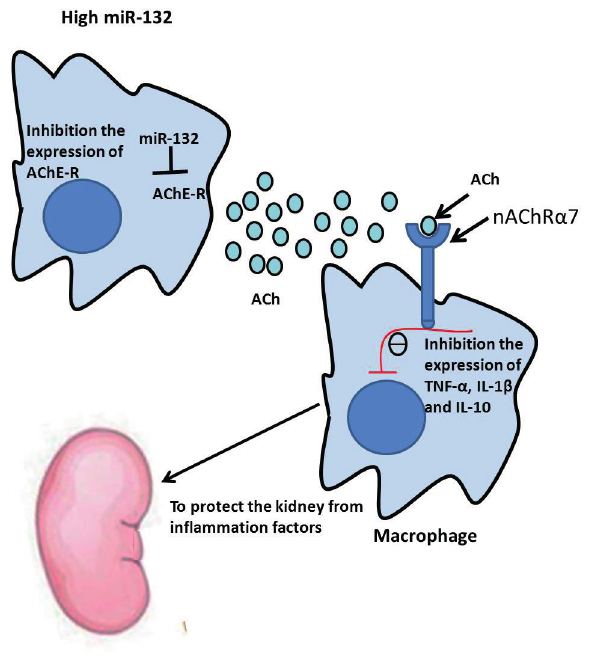
Figure 6: A schematic of the cholinergic anti-inflammatory impact. ACh-mediated anti- inflammatory response was increased by miRNA- 132 in the renal macrophage. MiRNA-132 can target the 3’-UTR of AChE mRNA to inhibit AChE expression and decrease the hydrolysis of ACh. nAChRα7 in monocyte– macrophages is activated by ACh to subsequently inhibit the activation of monocyte– macrophage and reduce the release of pro-inflammatory cytokines, such as TNF-α, IL- 1β, and IL-10. MiRNA-132 can inhibit macrophage activation through the role of the above mentioned and protect the